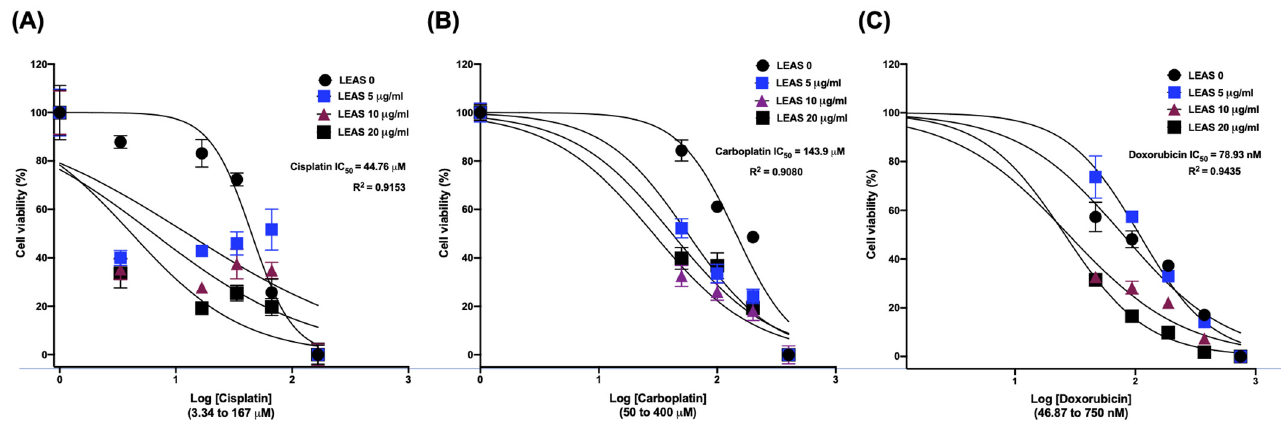
Figure 8. Synergistic effect of LEAS with cytostatic drugs on cell viability of D-17 cells. ( A ) Cisplatin, ( B ) Carboplatin, and ( C ) Doxorubicin . D-17 cells were subjected to the simultaneous treatment with LEAS (5, 10, 20, 50 µg/mL), cisplatin (3.34, 16.7, 33.4, 66.8 µM), carboplatin (50, 100, 200, 400 µM) or doxorubicin (46.8, 97.7, 187, 350 nM) and incubated for 72 h. The viable cells were determined by MTT assay and the IC 50 was estimated. Controls consisting of cells treated with the individual compounds were included. All treatments were evaluated in two independent experiments performed by triplicate.